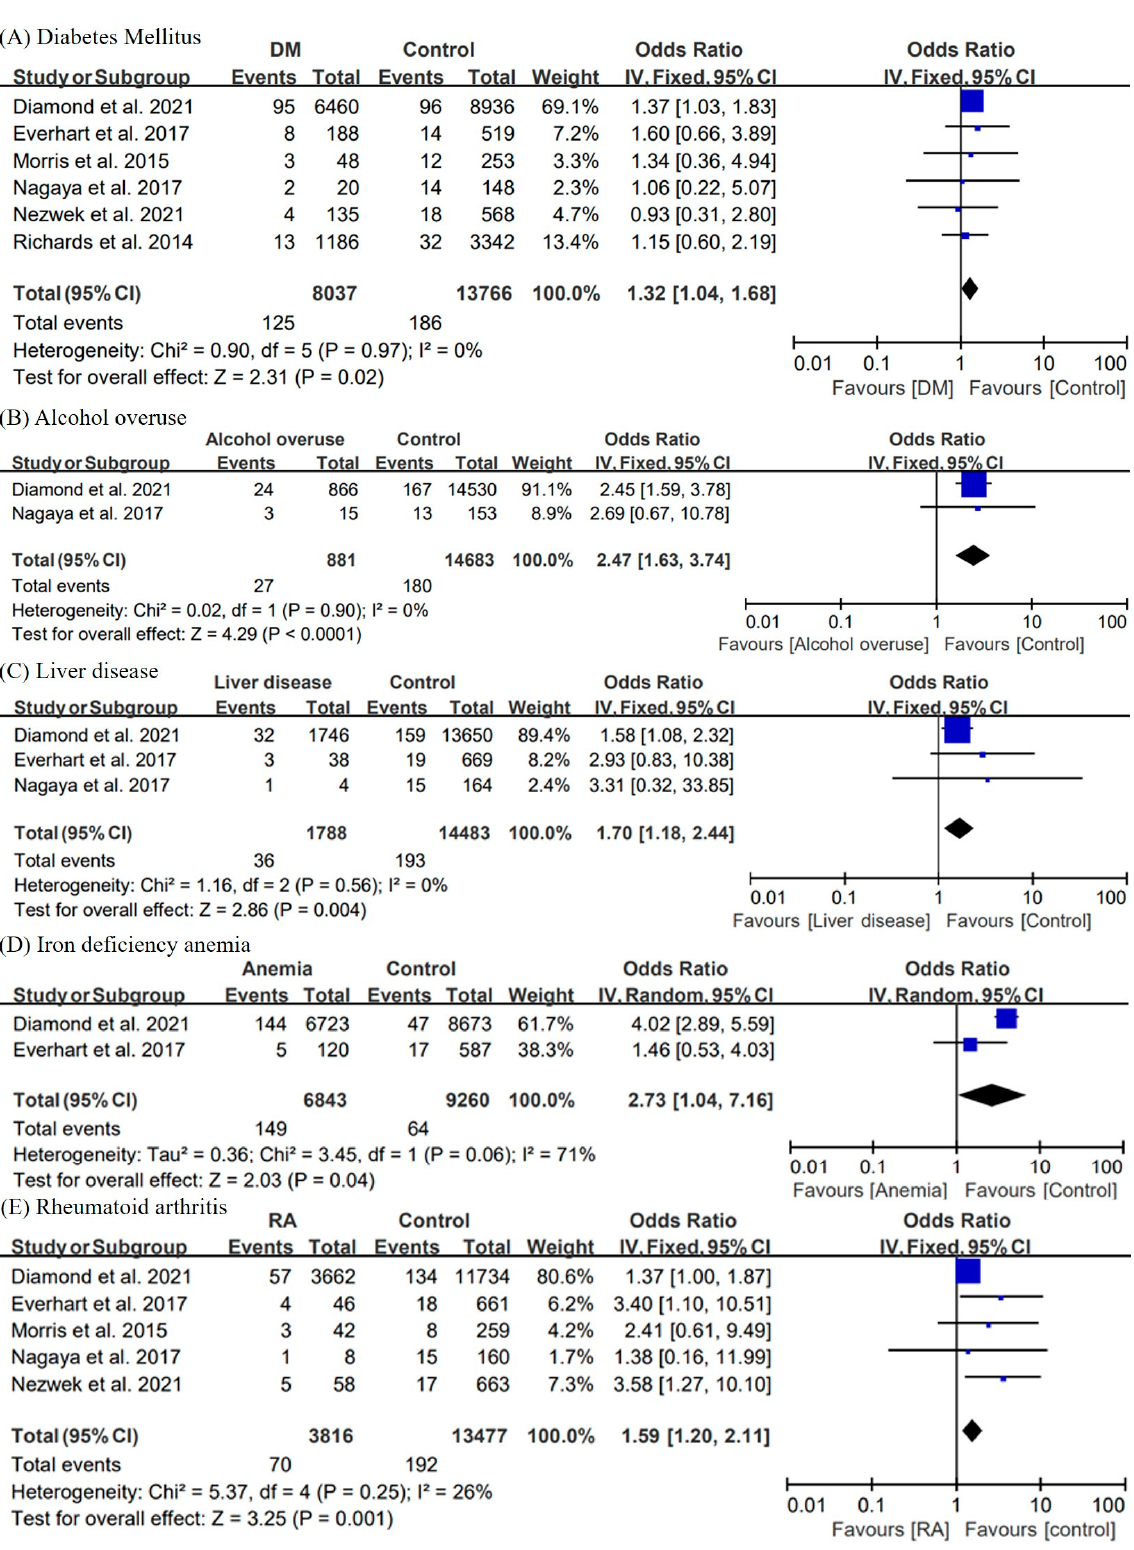
Figure 4. Forest plots, pooled odds ratio, 95% confidence interval, and heterogeneity for comorbidities. The risk factors analyzed in the comorbidities subgroups include the presence of previous ( A ) diabetes mellitus, ( B ) alcohol overuse, ( C ) liver disease, ( D ) iron-deficiency anemia, and ( E ) rheumatoid arthritis. DM, diabetes mellitus